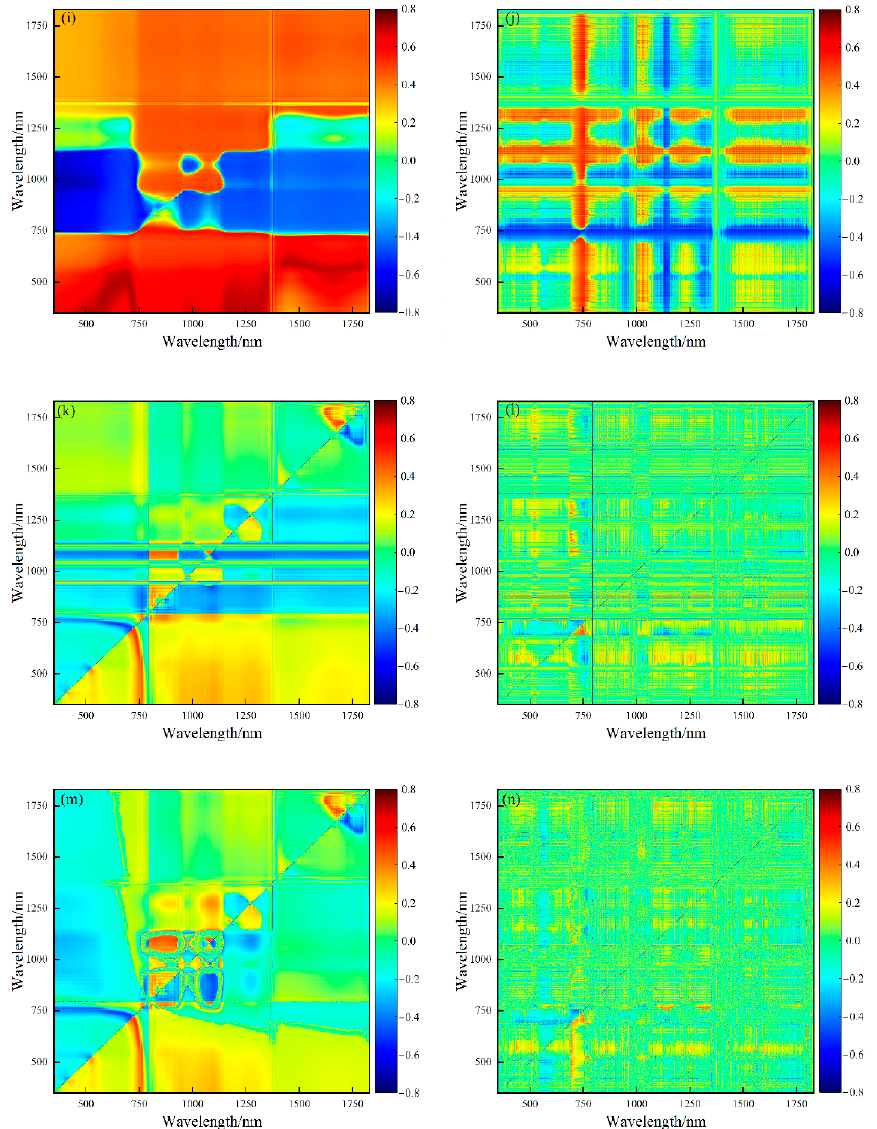
Figure 3. Correlation matrix diagram of spectral indices and leaf area index(LAI). ( a ) DI and LAI; ( b ) FDDI and LAI; ( c ) RI and LAI; ( d ) FDRI and LAI; ( e ) NDVI and LAI; ( f ) FDNDVI and LAI; ( g ) SAVI and LAI; ( h ) FDSAVI and LAI; ( i ) TVI and LAI; ( j ) FDTVI and LAI; ( k ) mSR and LAI; ( l ) FDmSR and LAI; ( m ) mNDI and LAI; ( n ) FDmNDI and LAI. Table 3. The maximum value and wavelength position of correlation coefficient between spectral index and leaf area index.